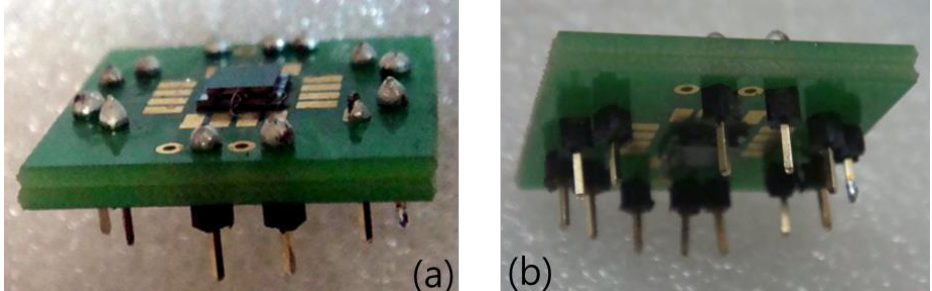
Figure 13. The structure of the accelerometer for the Z-axis.